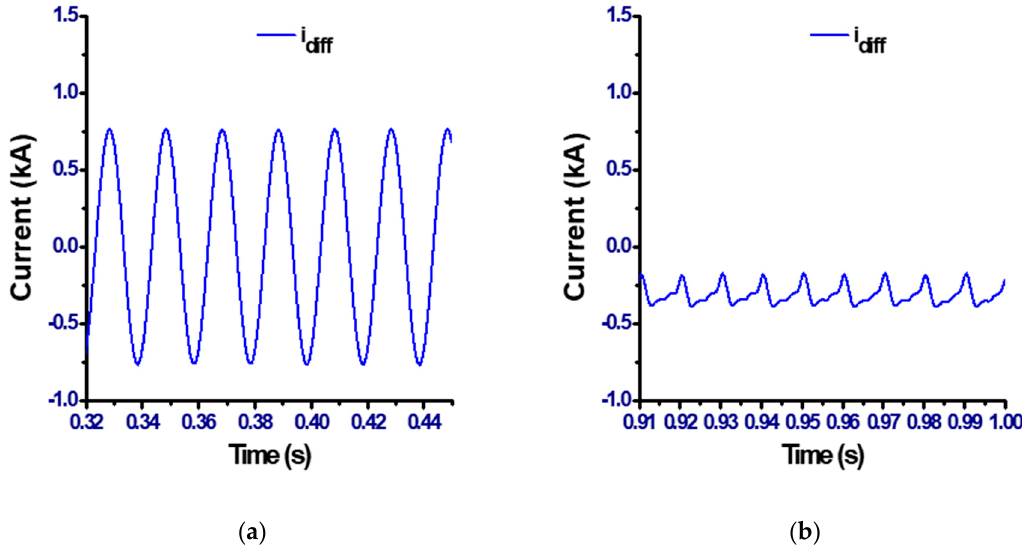
Figure 9. Results of ( a ) circulating current-direct modulation and ( b ) circulating current-proposed direct modulation method.